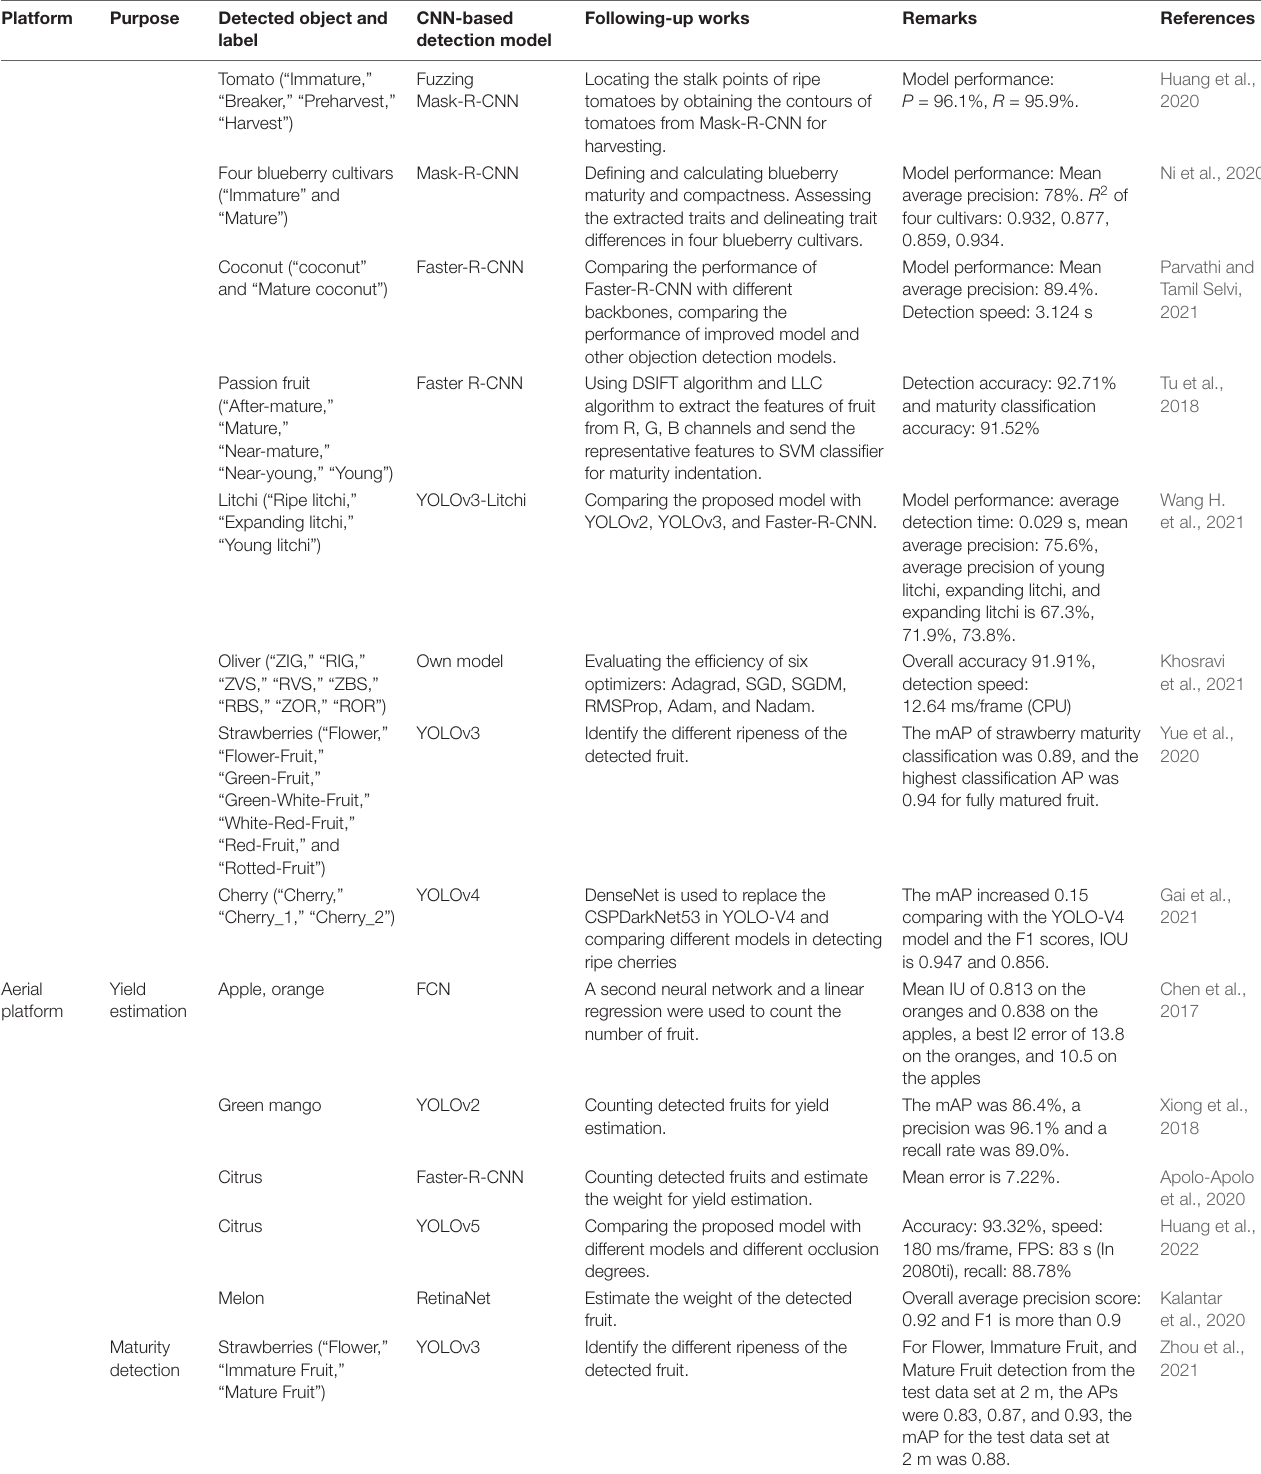
two modes displayed in Figure 14 . The background